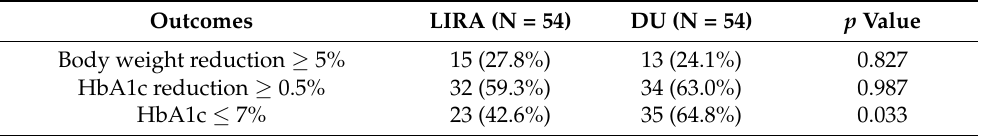
Table 5. Comparative efficacy between dulaglutide (DU) 1.5 mg/once weekly and liraglutide (LIRA) 1.2–1.8 mg/once daily as add-on to MET or MET plus conventional insulin secretagogues, after 18 months of continuous